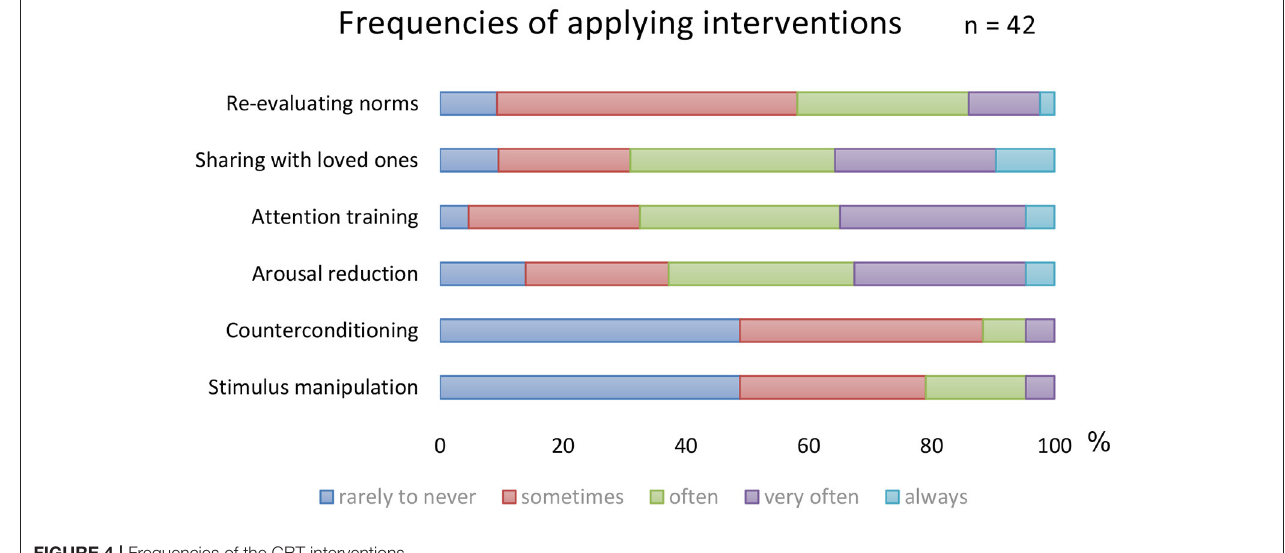
FIGURE 4 | Frequencies of the CBT interventions.